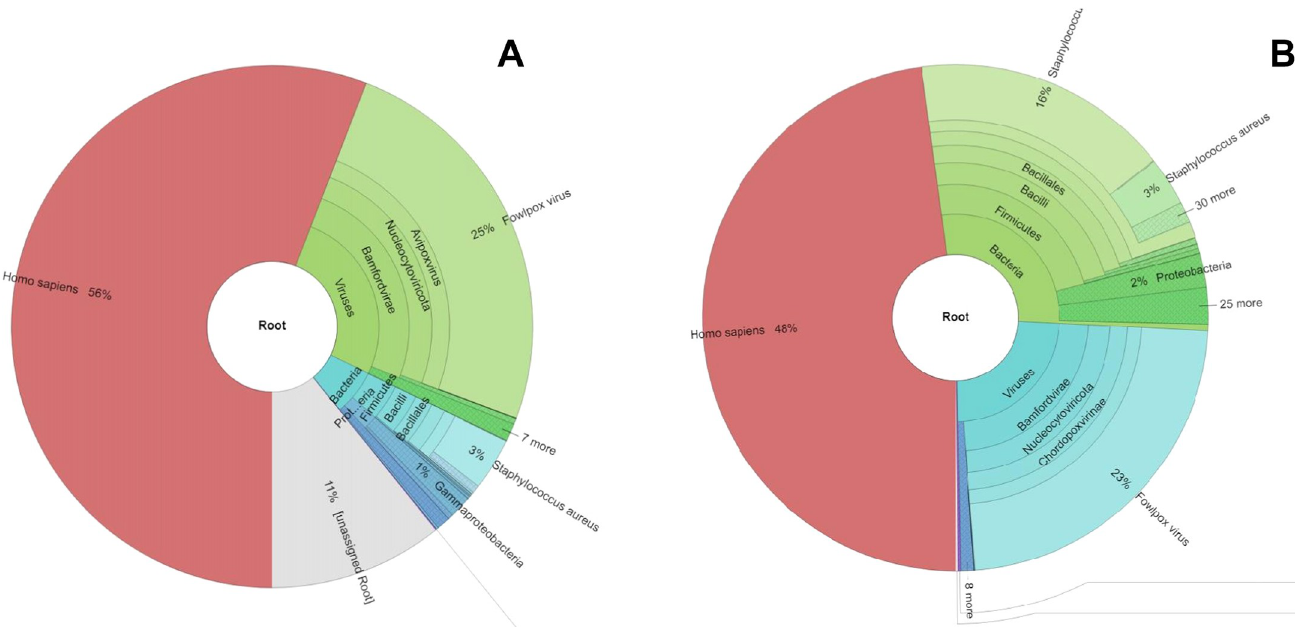
Fig 2. Taxonomic classification of FPV-CAMs (A) and FPV-COMB (B) using Kraken2 and visualised by Krona pie chart. Reads identified as homo sapiens are a result of Gallus gallus not being present in the smaller Kraken2 database utilised.